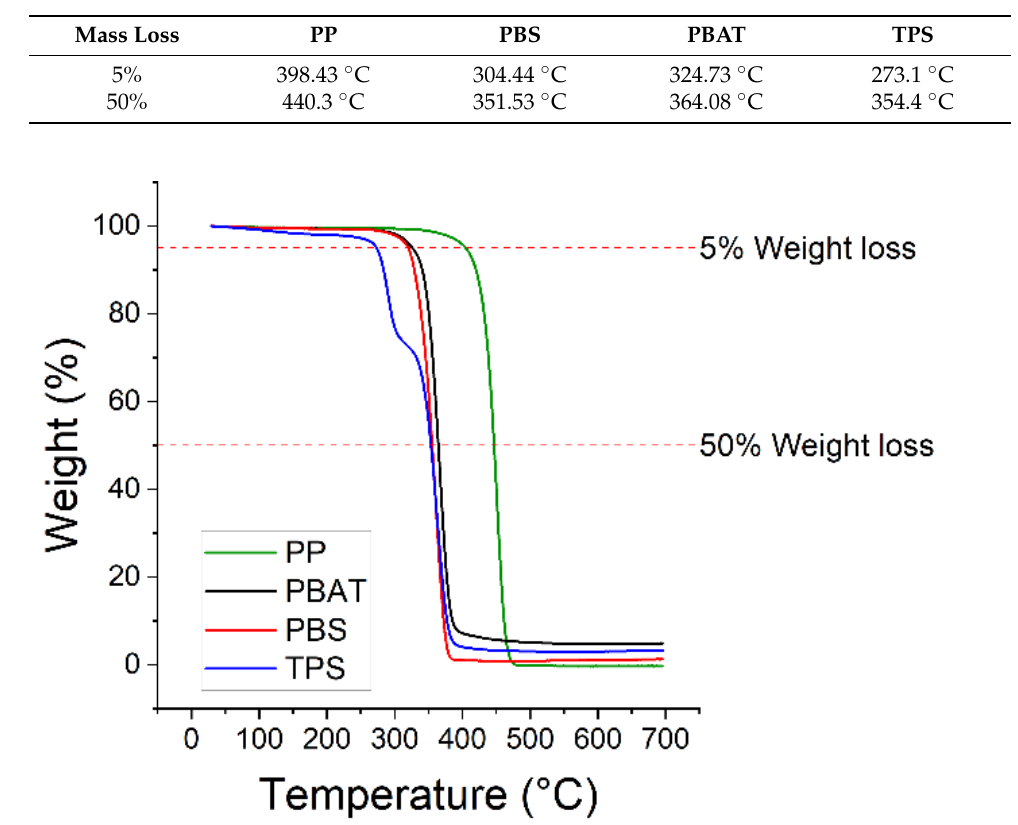
Figure 2. Thermograms showing the temperatures of 5% and 50% mass loss for four polymers. The highest temperatures of 5% and 50% mass loss were observed for PP. PBS and PBAT showed similar values, which were much lower than PP. However, the curves